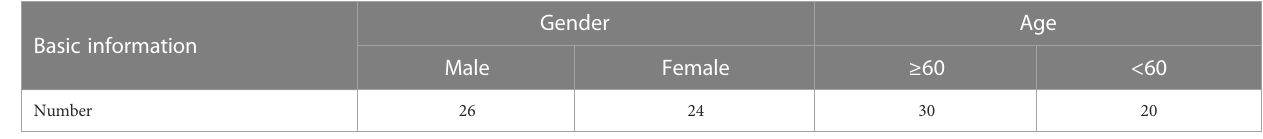
TABLE 1 Basic information of the NSCLC patients.